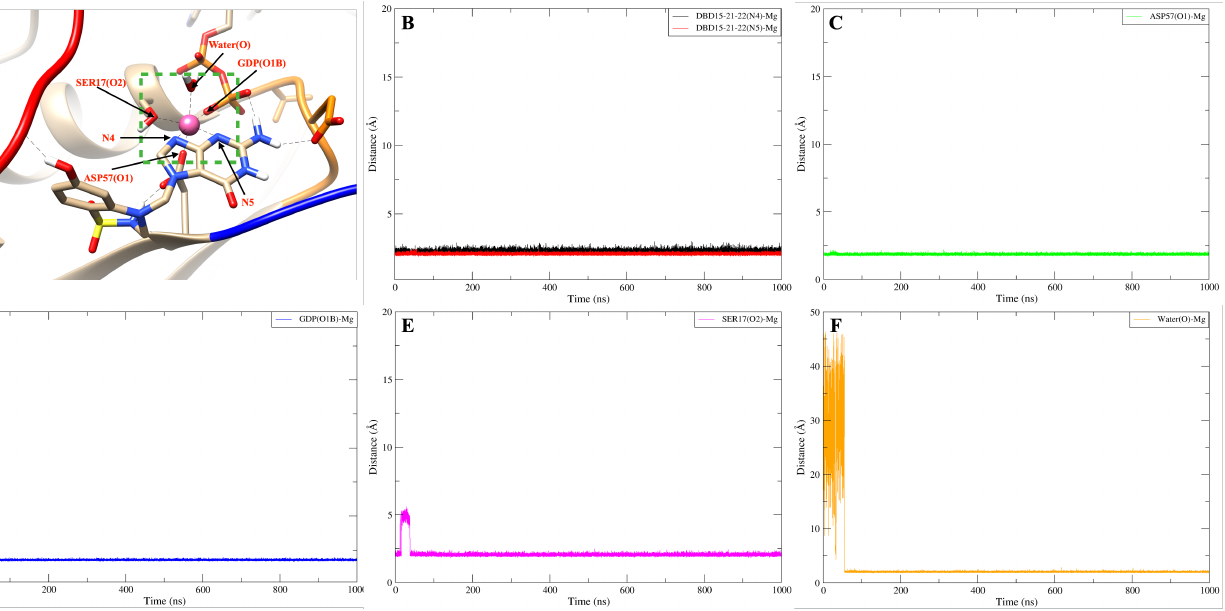
Figure A16. The DBD15-21-22 (H11) can form hydrogen bond interactions with THR35, ILE36 and GLU37. ( A ) Representative snapshot of DBD15-21-22 (H11) forming hydrogen bond interactions with THR35, ILE36 and GLU37; ( B ) distance between DBD15-21-22 (H11) and three SW-I residues (THR35, ILE36, GLU37).